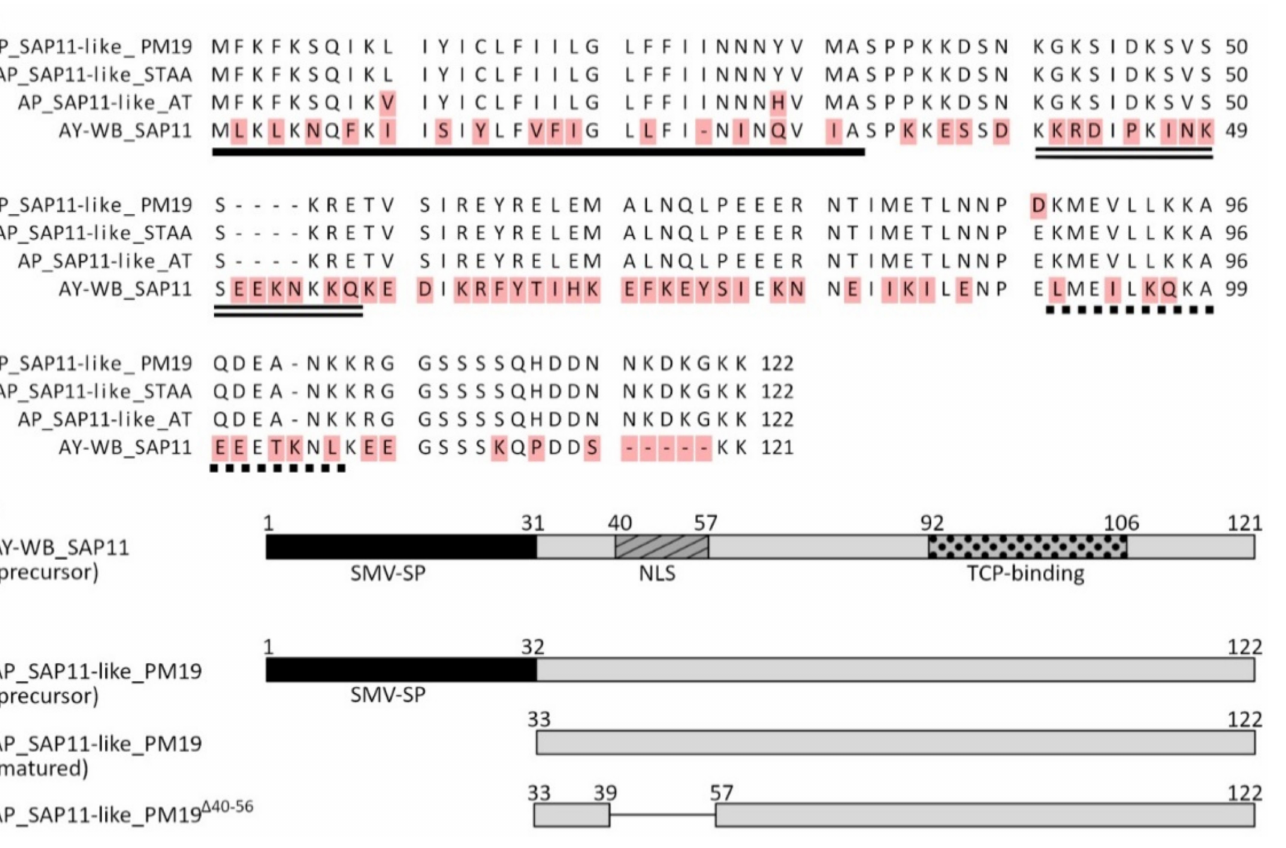
Figure 1. Sequence alignment and schematic representation of the AP_SAP11-like_PM19 amino acid sequence used in this study. ( a ) Multiple sequence alignment of AP_SAP11-like protein of strains PM19, STAA and AT, and AY-WB_SAP11. Annotations: single black line represents sequence-variable mosaic protein signal peptide (SVM-SP), double black line represents nuclear leader sequence (NLS), and the dotted line represents TCP-binding area of AY-WB_SAP11. ( b ) Schematic representation of deletions and additions to AP_SAP11-like_PM19 in comparison to AY-WB_SAP11. The black squares represent the SVM-SP, the striated squares represent the NLS, and the dotted squares represent the TCP-binding area. The deletion of amino acids 40 to 56 in AP_SAP11-like_PM19 ∆ 40–56 is indicated by a line connecting the